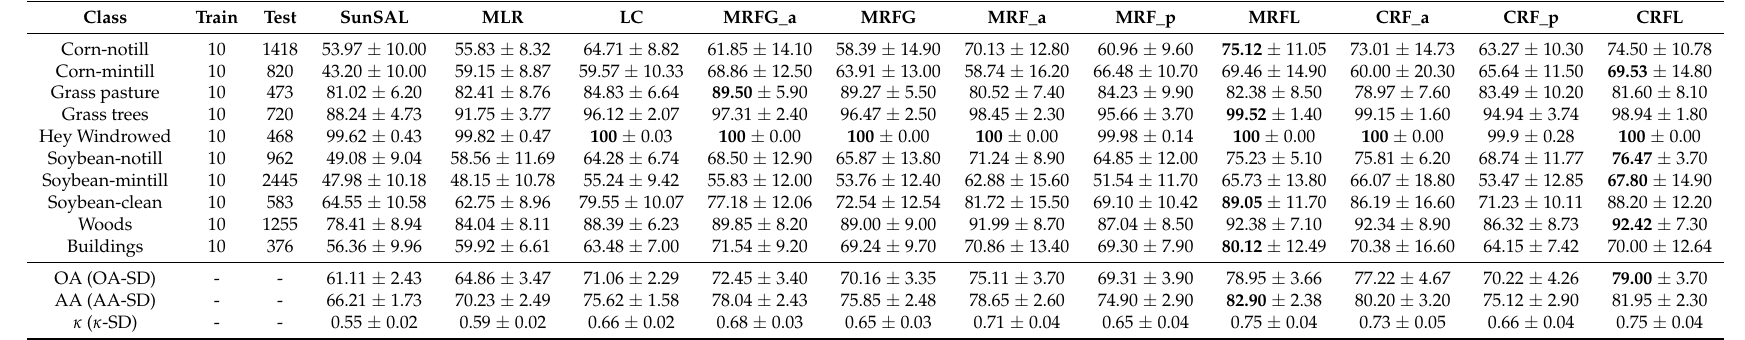
Table 3. Classification accuracies [%] with their standard deviations for the Indian Pines image (the highest accuracies are denoted in